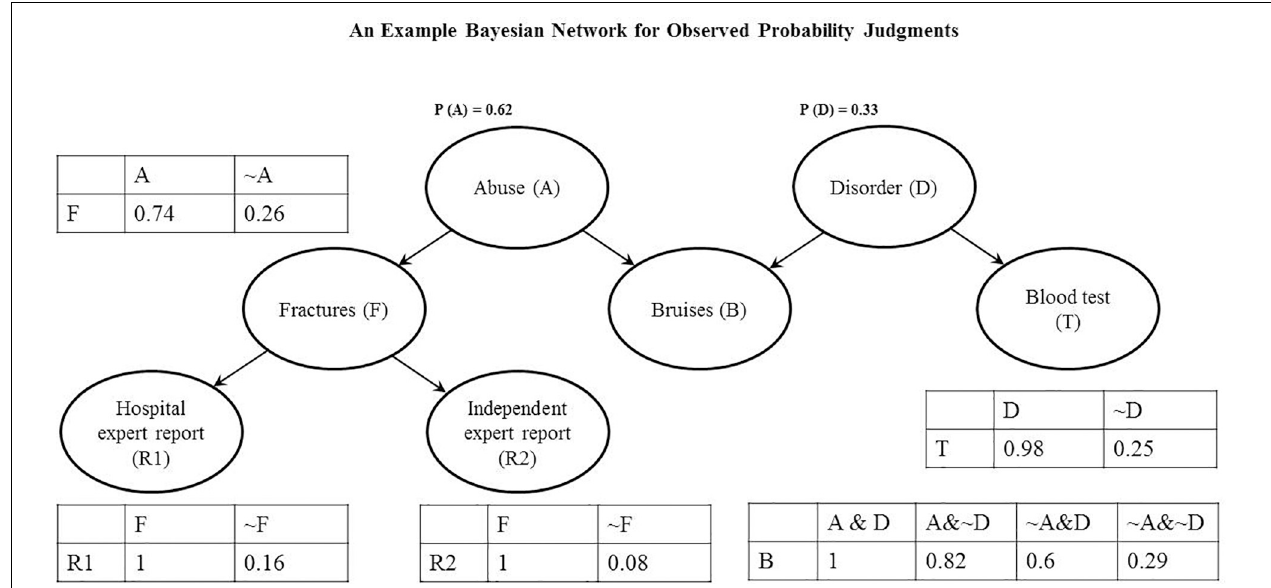
FIGURE 4 | Individual Bayesian Network: The graph shows a Causal Bayesian Network and corresponding probability tables for one of the participants from Experiment